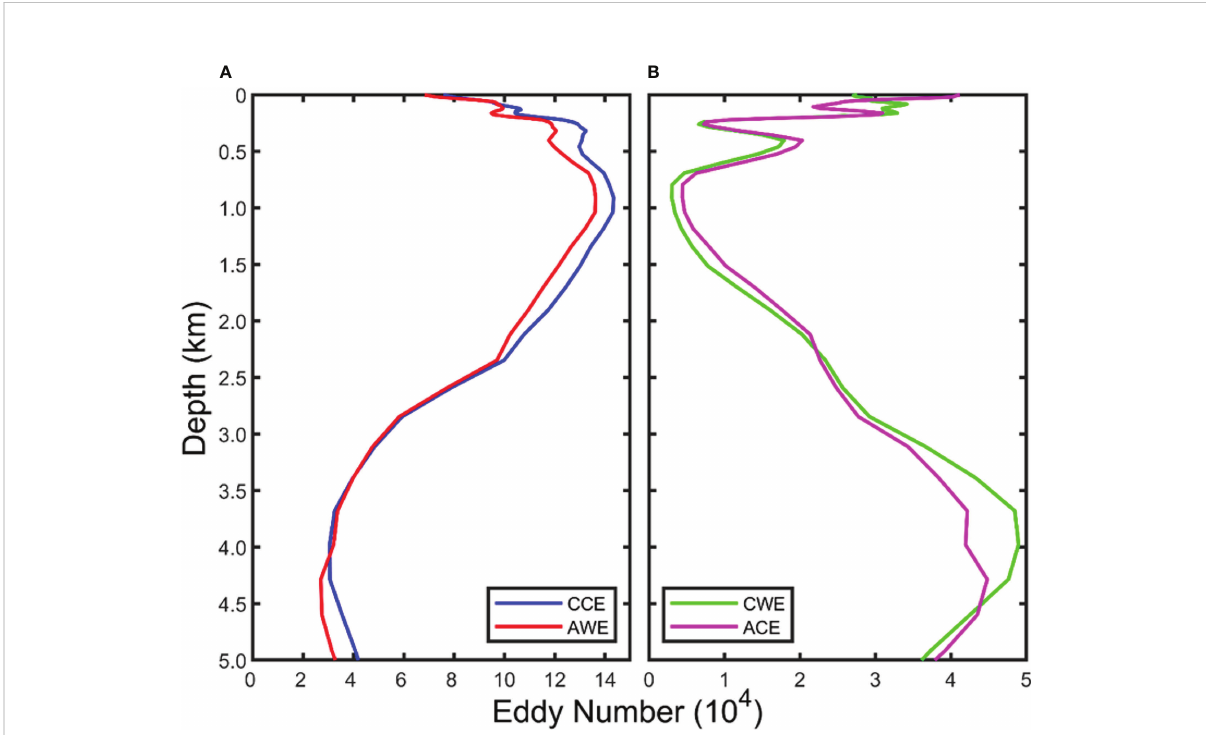
FIGURE 4 Vertical distribution of four types of eddies ’ number in the STCC region. Blue, red, green, and magenta curves represent cyclonic cold-core eddy (A) , anticyclonic warm-core eddy (A) , cyclonic warm-core eddy (B) , and, anticyclonic cold-core eddy (B) ,